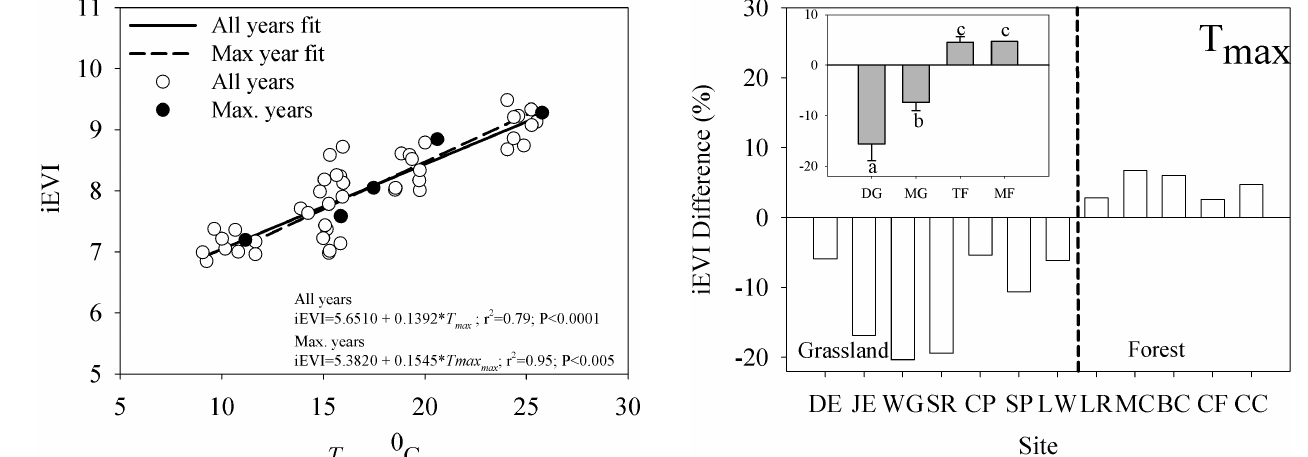
Figure 3. Relationship between iEVI and T max and their maximum- year T max –iEVI relationship for five forested sites. The dotted line shows the linear relationship between maximum-year T max and the relevant iEVI for all the sites.